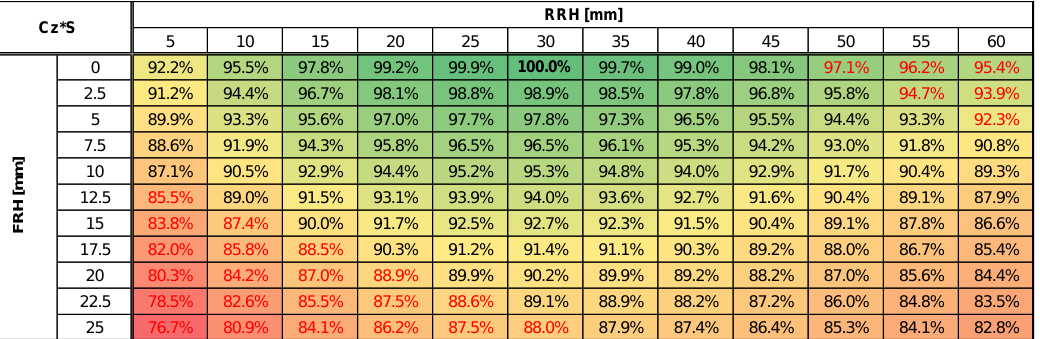
Figure 7. Downforce coefficient C Z S vs. FRH and RRH. The percentage variation is computed with reference to maximum downforce, corresponding to FRH = 0 mm, RRH = 30 mm. Background colors highlight the C Z S trend: in this case green is the best (highest) downforce zone, while red is the lowest.